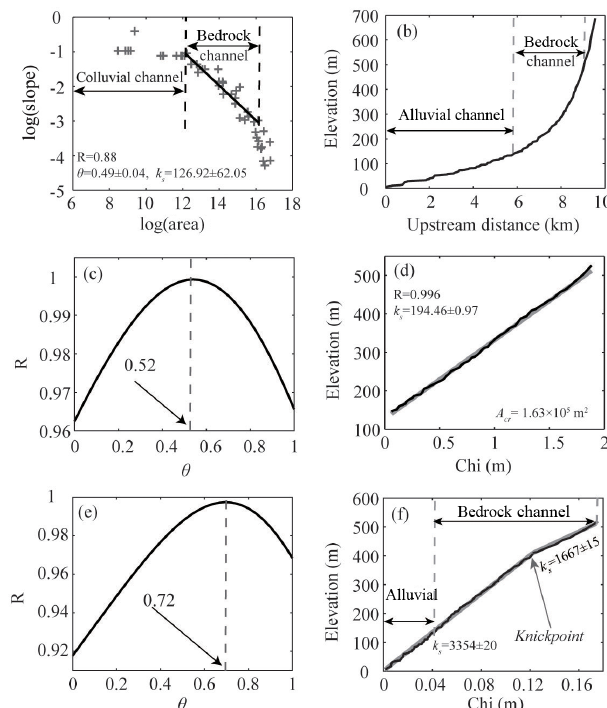
Figure 4. Stream profile analysis of Juan stream. (a) Log- transformed slope–area plot. The slope was derived from the smoothed (horizontal distance of 300m) and re-sampled (elevation interval of 20m) elevation data. (b) The full river profile (without any smoothing or re-sampling) of Juan stream. (c) The correlation coefficients of χ − z plots as a function of θ for the bedrock portion of the river. The maximum value of R occurs at θ = 0.52. (d) χ − z plot of the bedrock channel profile based on a concavity value of 0.52. (e) The correlation coefficients of χ − z plots as a function of θ for fluvial (both bedrock and alluvial) channel. The maximum value of R occurs at θ = 0.72. (f) χ − z plot of the fluvial (both bedrock and alluvial) channel profile based on a concavity value of